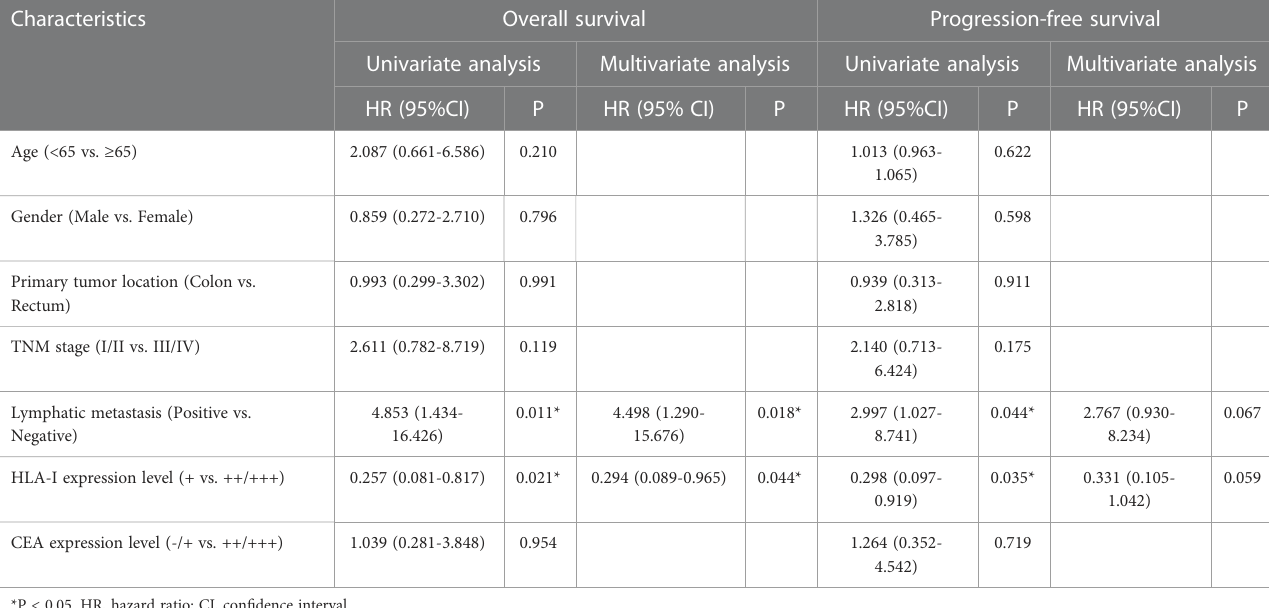
TABLE 2 Univariate and multivariate analyses of overall survival and progression-free survival in patients administered CTL infusion.